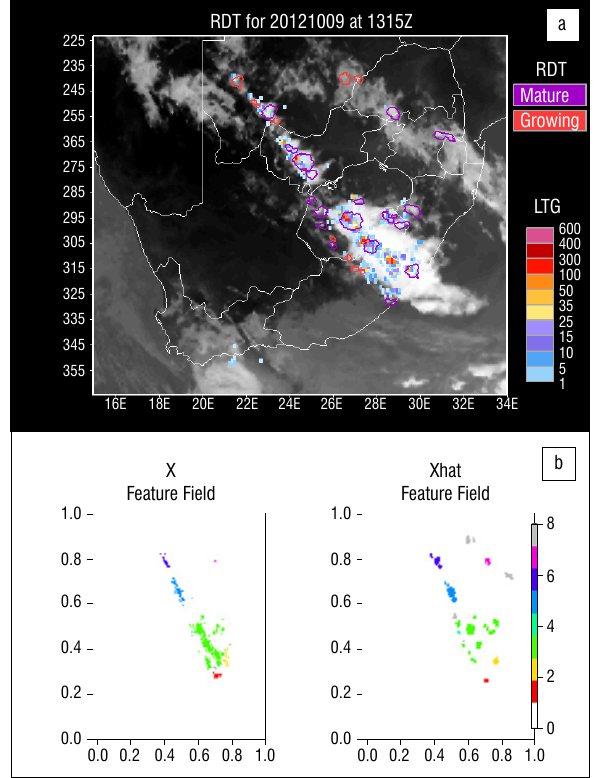
Figure 1: (a) RDT data for 9 October 2012 at 13:15 UTC, overlaid on IR 10.8 channel. Lightning intensity is given by the different colours as indicated by the palette. (b) Object-orientated comparison for the lightning occurrence (left) and RDT product (right). The colours indicate which objects match with which; grey indicates false alarms and misses.